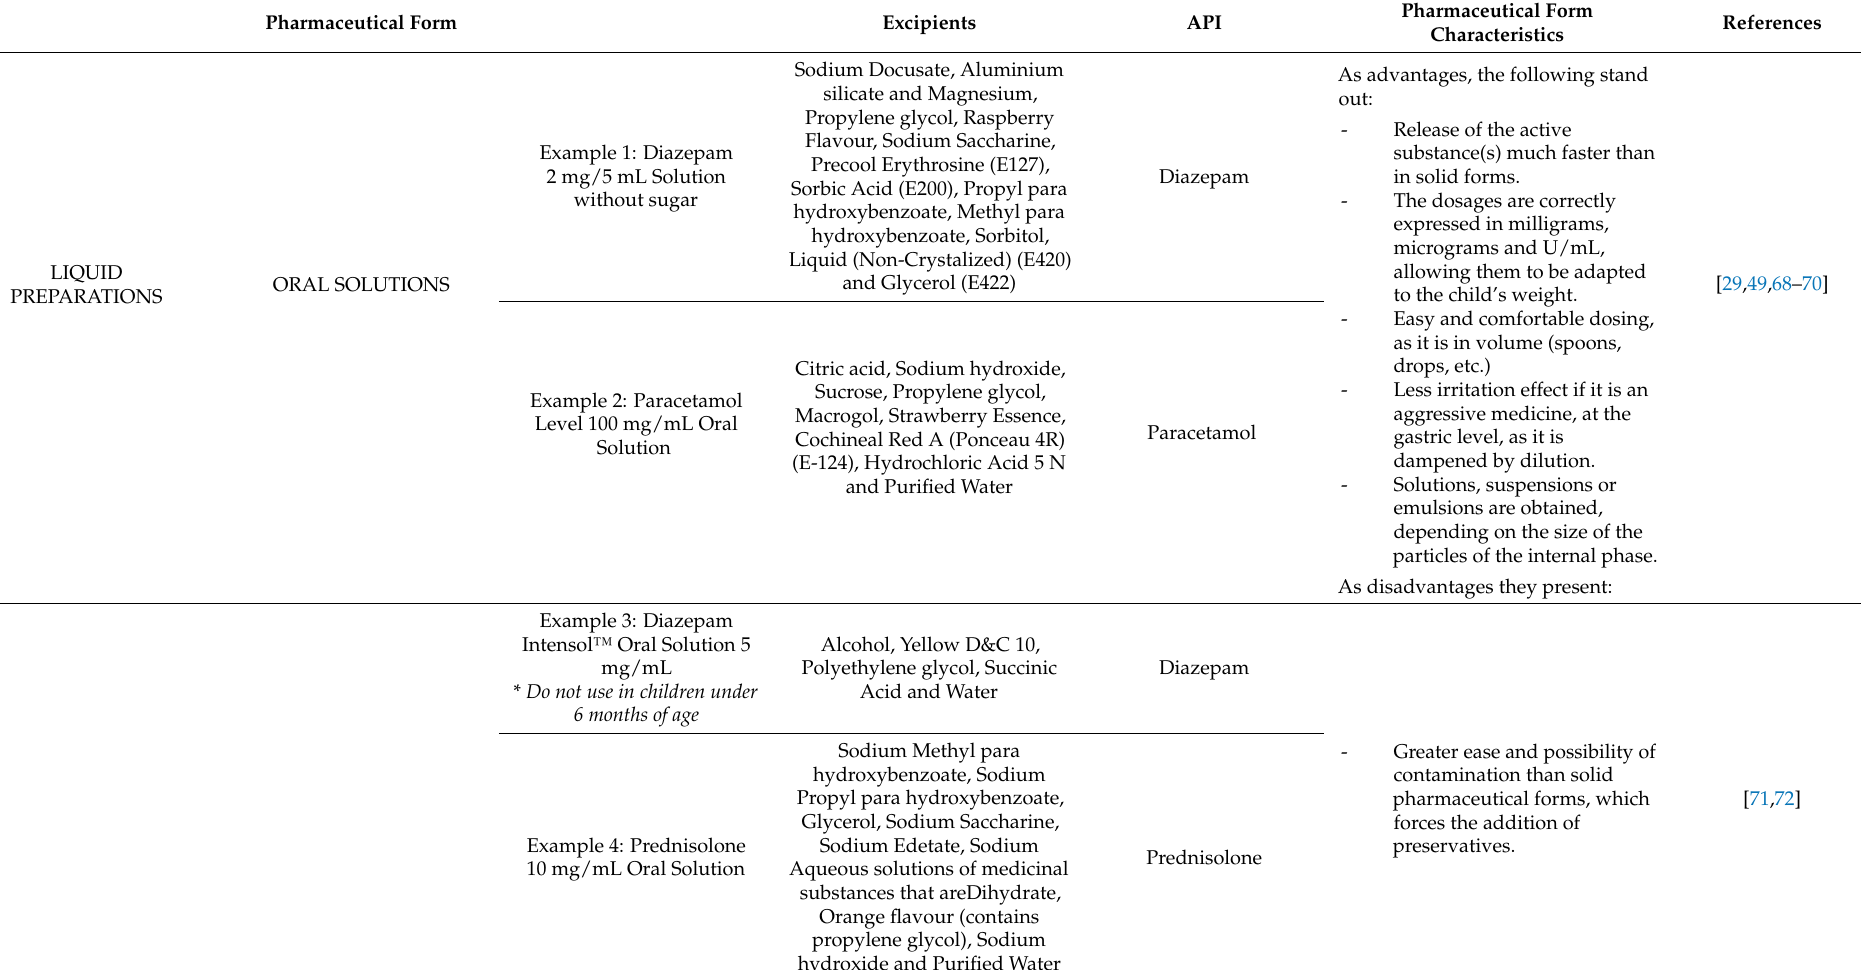
Table A3. Examples of liquid medicines used in paediatrics: List of excipients and relevant characteristics of Pharmaceutical